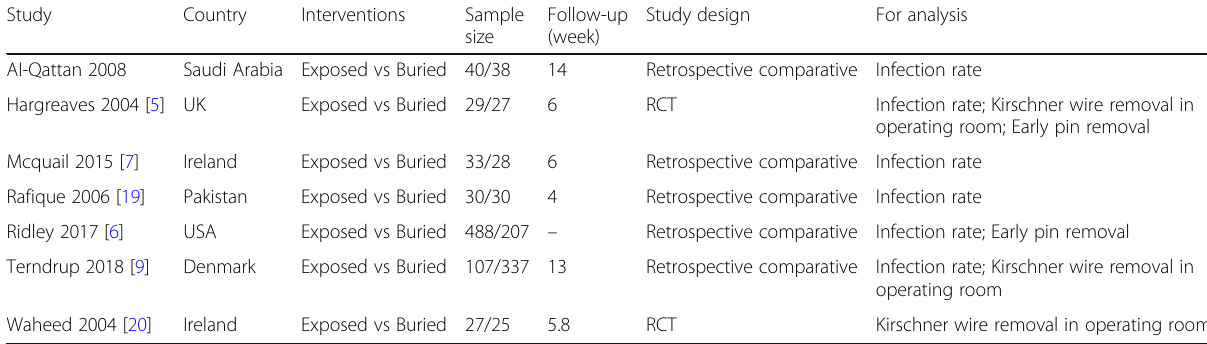
Table 2 Characteristics of included studies comparing buried versus exposed Kirschner wire osteosynthesis for phalangeal, metacarpal and distal radial